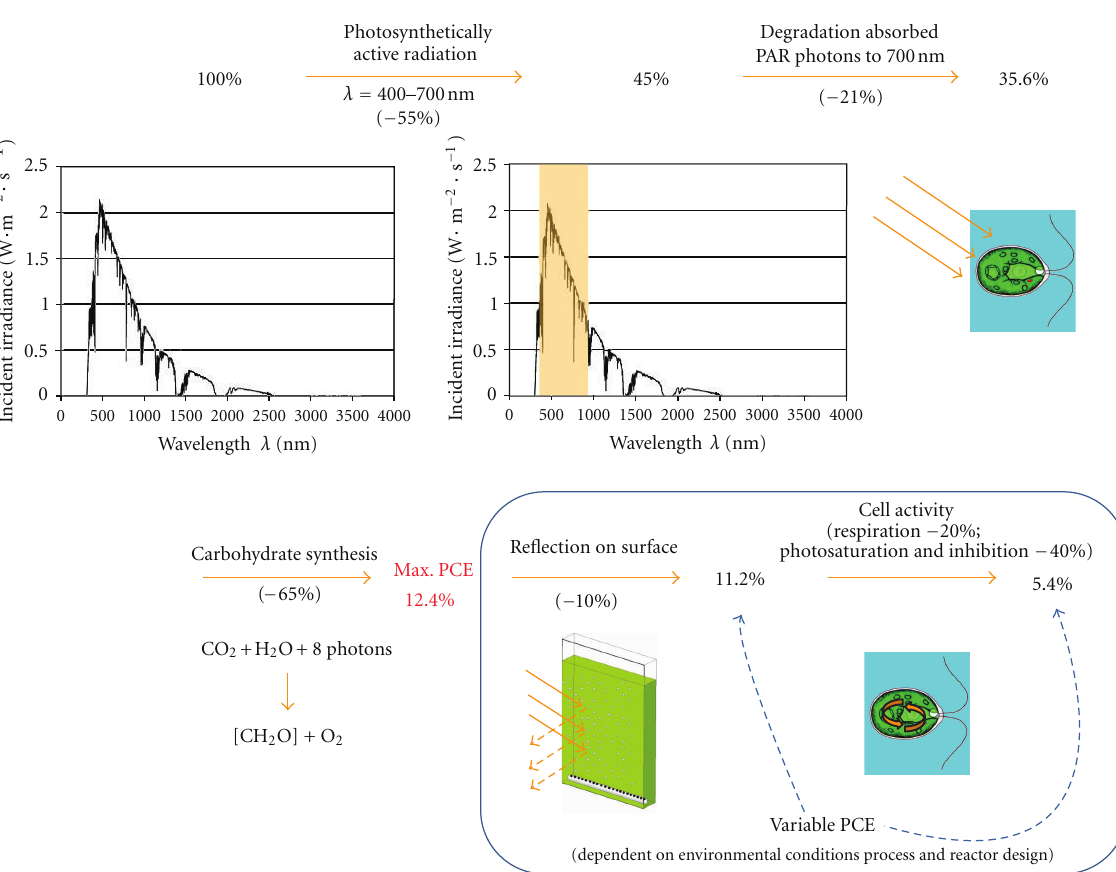
Figure 1: E ff ects causing energy losses during the conversion of sunlight into biomass (based on data from